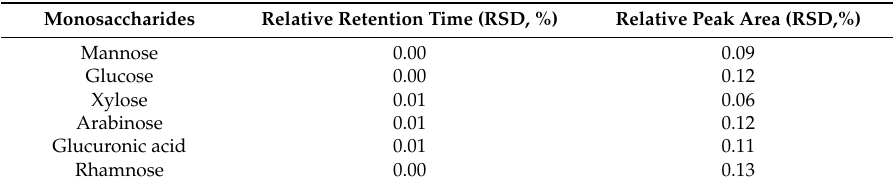
Table 2. Statistical results of the reference monosaccharides ( n = 5).